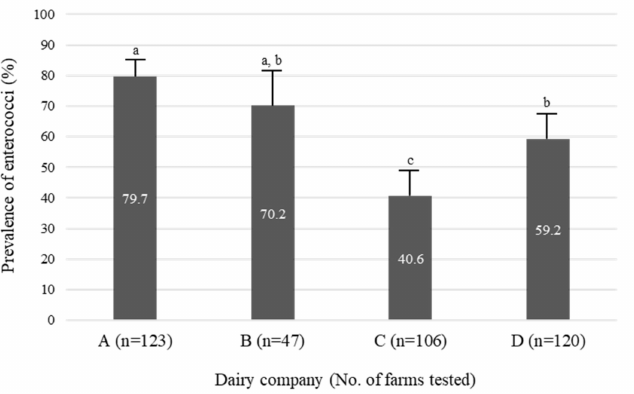
Figure 1. Prevalence of Enterococcus faecalis and Enterococcus faecium in bulk tank milk samples from four dairy companies. Values not sharing a common subscript letter (a, b, c) are statiscally different ( p <